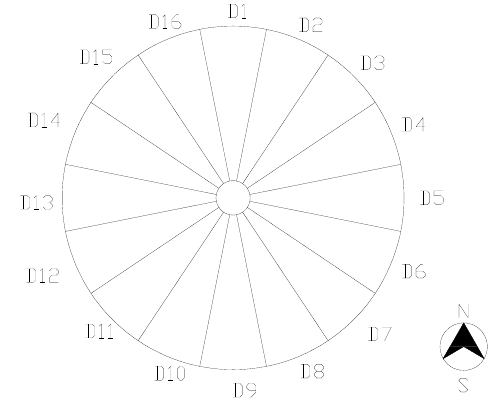
Figure 9. Definition of the wind direction azimuth.